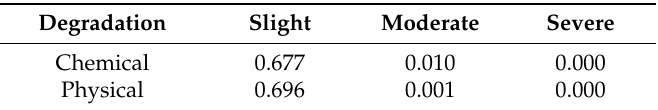
Table 2. Biomass extraction factors according to soil degradation and degree.